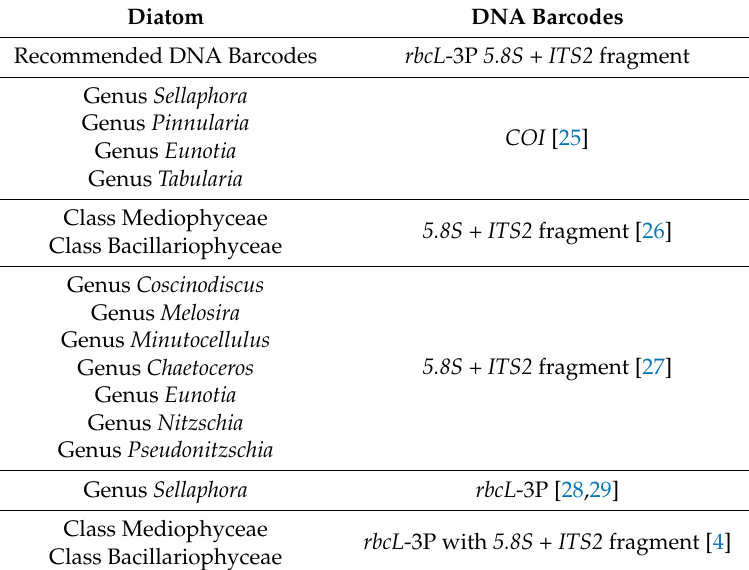
Table 2. Commonly used DNA barcodes in Diatom.